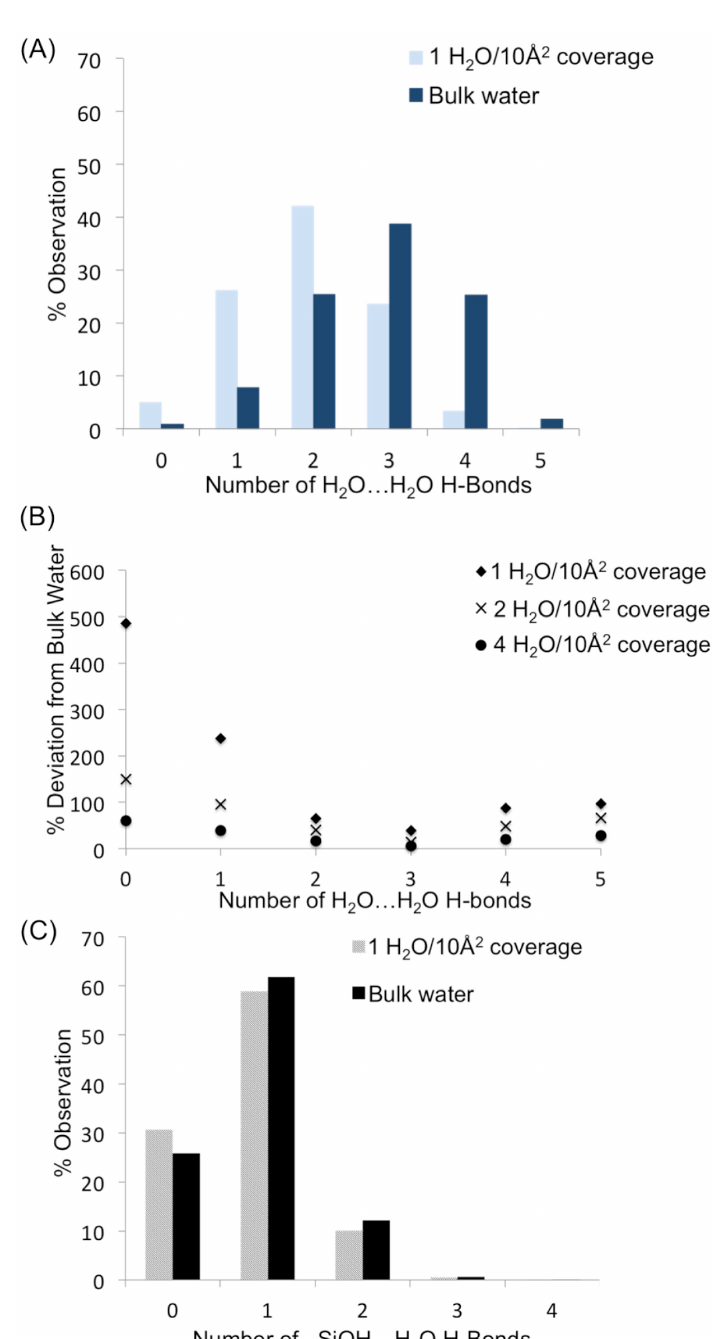
water molecules. ( B ) Convergence of water-water hydrogen bond distributions toward